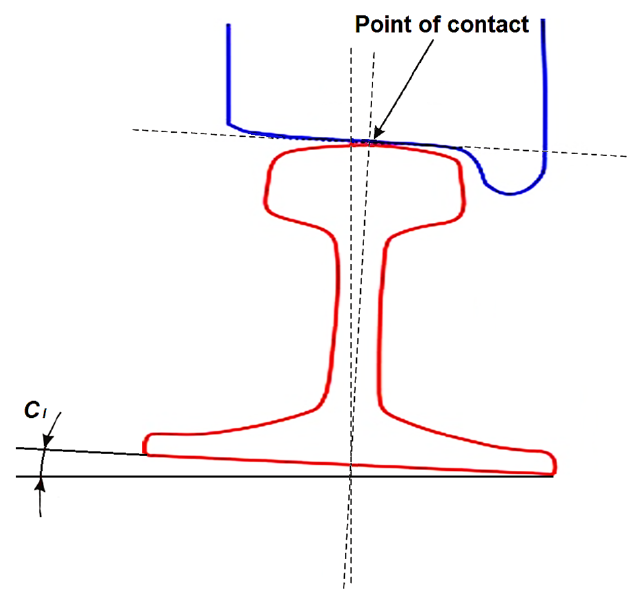
Figure 1. Rail inclination C l .